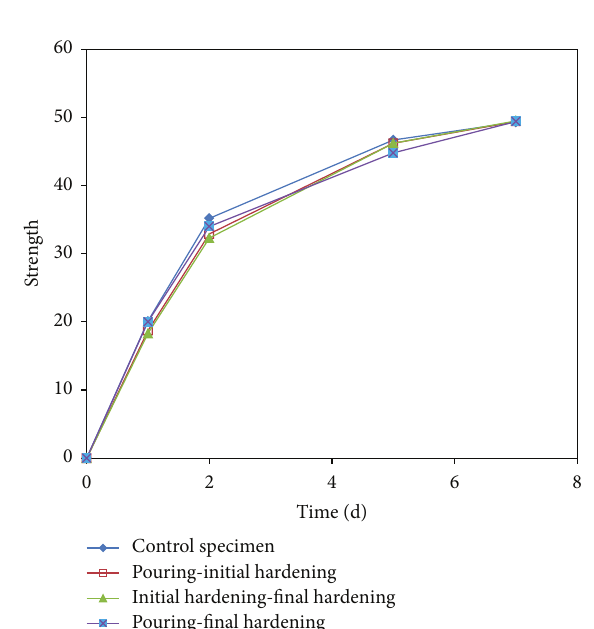
Figure 5: Compressive strength and rate of change of HPC speci- mens with vibration parameters of 2 Hz and 3